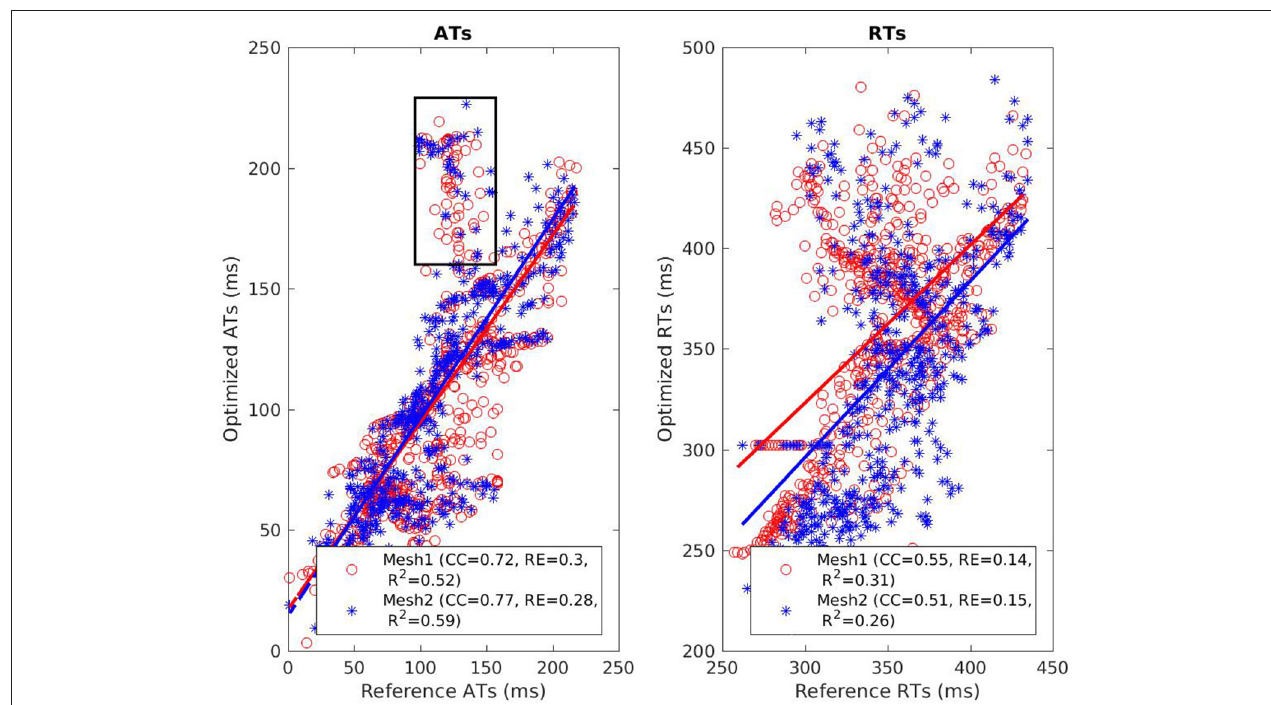
FIGURE 5 | Scatter plot of the ATs (left) and RTs (right) for the RV pacing case. For each point, the x coordinate is the reference AT (resp. RT) and the y coordinate is the corresponding reconstructed AT (resp. RT). The dashed lines represent the linear fitting. The black box on the left exhibits ATs that were badly reconstructed with both meshes.